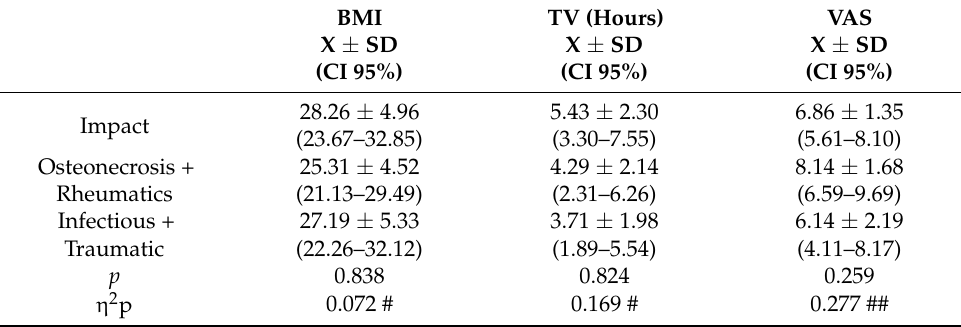
Table 3. Body mass index (BMI), television time (Hours), visual analogic scale (VAS), (average ± SD) in different types of pathology